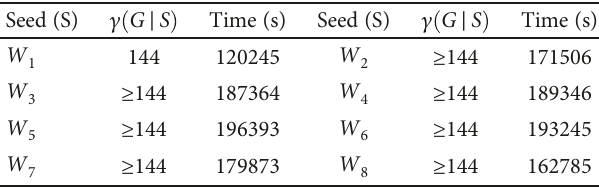
Figure 5: A dominating set with 144 vertices in C Table 4: The results for extending seeds from S